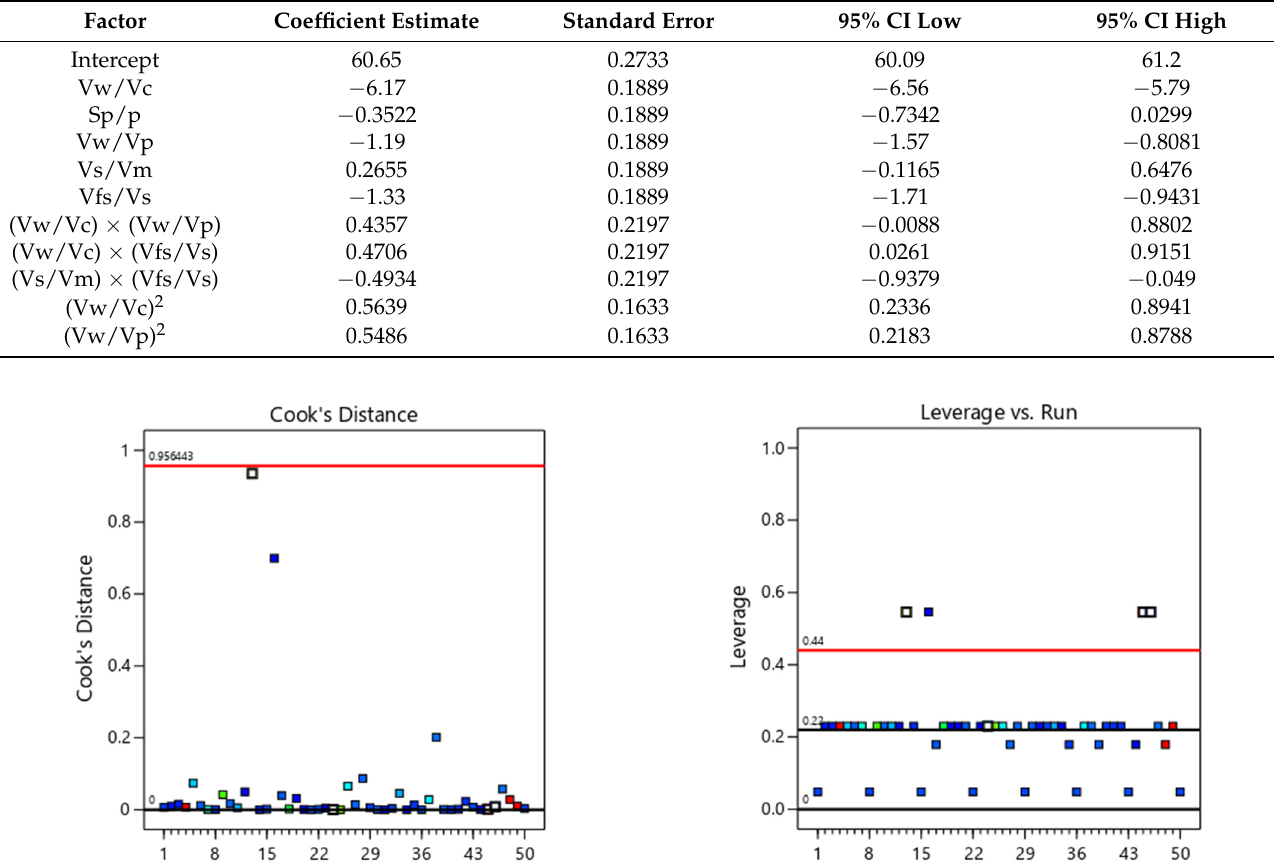
Table 12. Rc,24 h model coefficients in terms of coded values.